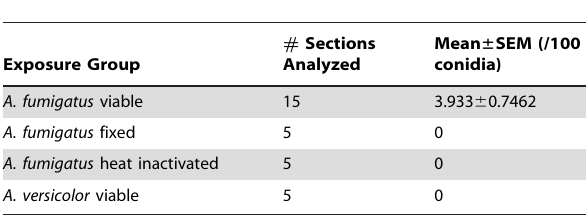
Table 1. Summary of Conidia Germination in Lung